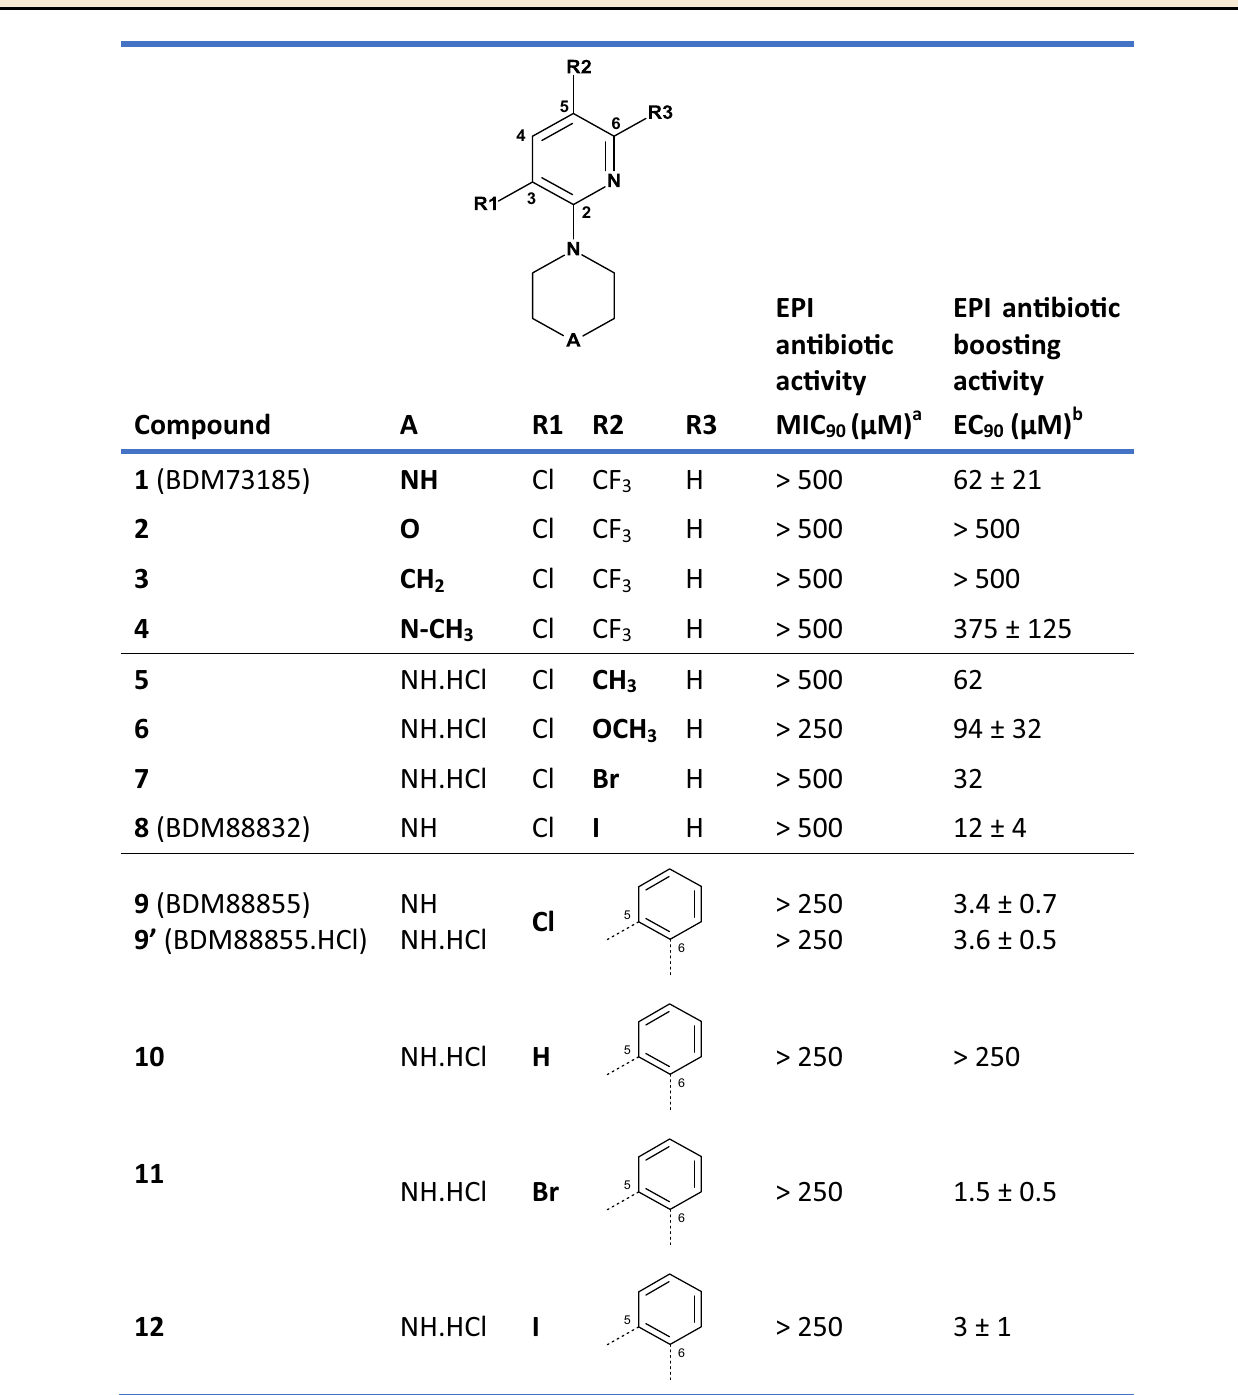
Table 1 Biological activities of compounds 1 –